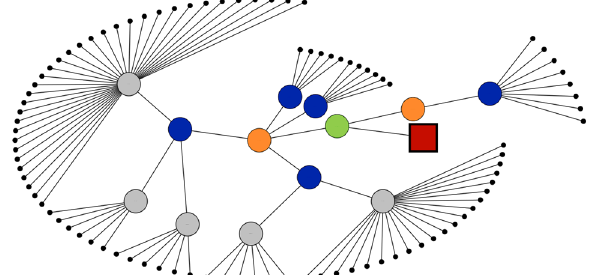
Figure 4: tree-structure of a hundred laser scans (black) registered consecutively in sub-networks (grey > blue > orange > green), up to referencing to external coordinate system using control points (red